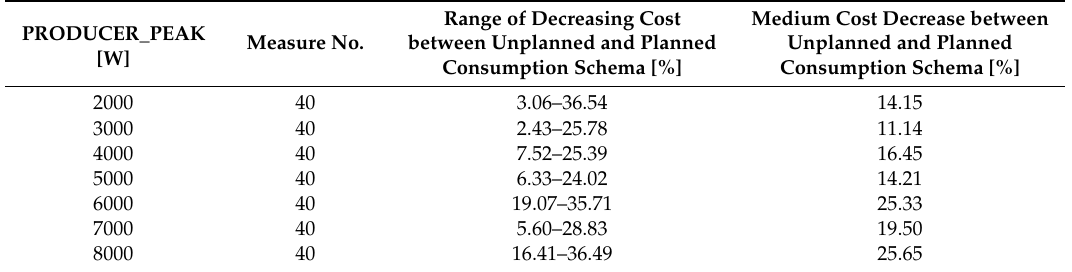
Table 5. Results from a set of measurements in which PRODUCER_COST = 0.2 RON / 1